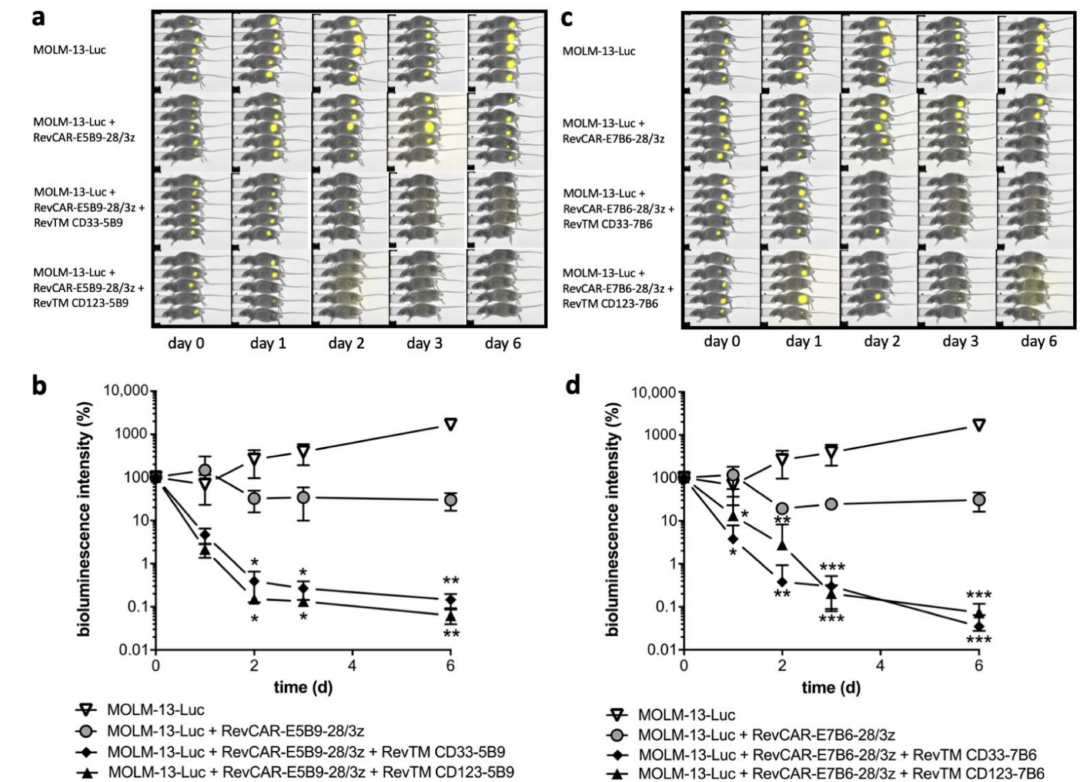
Figure 5. In vivo killing of MOLM-13 cells by the RevCAR system. Immunodeficient NMRI- Foxn1 nu/nu mice were injected with Luciferase (Luc) expressing MOLM-13-Luc cells alone, with MOLM-13-Luc cells together with either ( a , b ) RevCAR-E5B9-28/3z or ( c , d ) RevCAR-E7B6-28/3z T-cells without RevTMs or with MOLM-13-Luc cells and RevCAR T-cells in the presence of indicated RevTMs. ( a , c ) Bioluminescence imaging of anesthetized mice was performed at several time points. ( b , d ) The calculated quantitative values of all animals and time points are presented as mean values ± SEM of five animals (one-way ANOVA with Tukey’s multiple comparisons test. Significance versus MOLM-13-Luc + RevCAR- E5B9-28/3z or RevCAR-E7B6-28/3z.). The curves show the relative changes in bioluminescence intensity over the time normalized for each mouse to the starting luminescence at day 0. p values below 0.0332 were considered significant: p < 0.0332 (*), p < 0.0021 (**), p < 0.0002